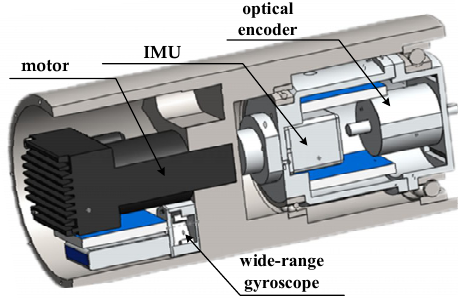
Figure 1. Main configuration of the semi-strapdown inertial navigation system (SSINS).